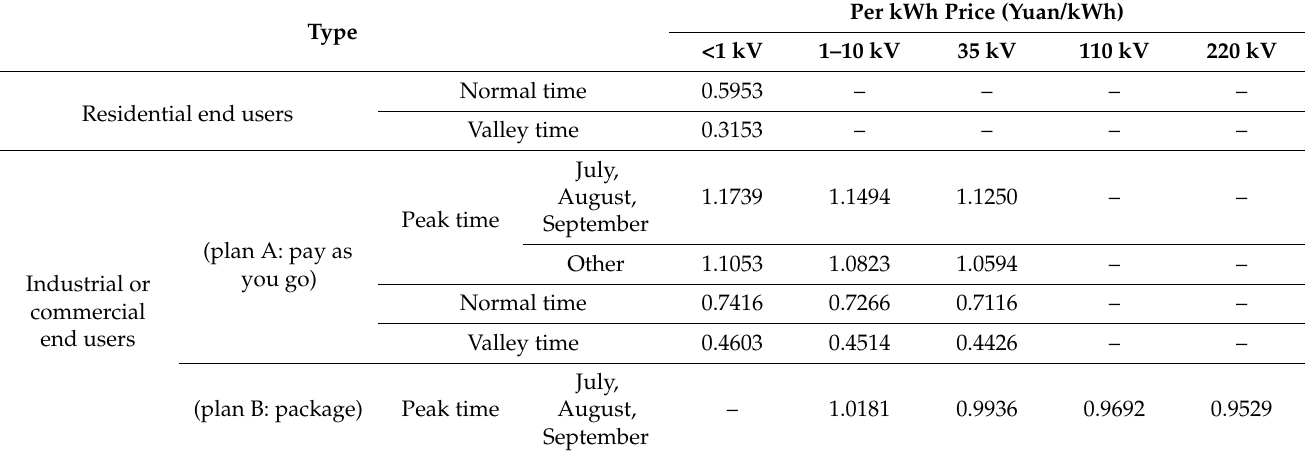
Table A1. End-user regulated prices